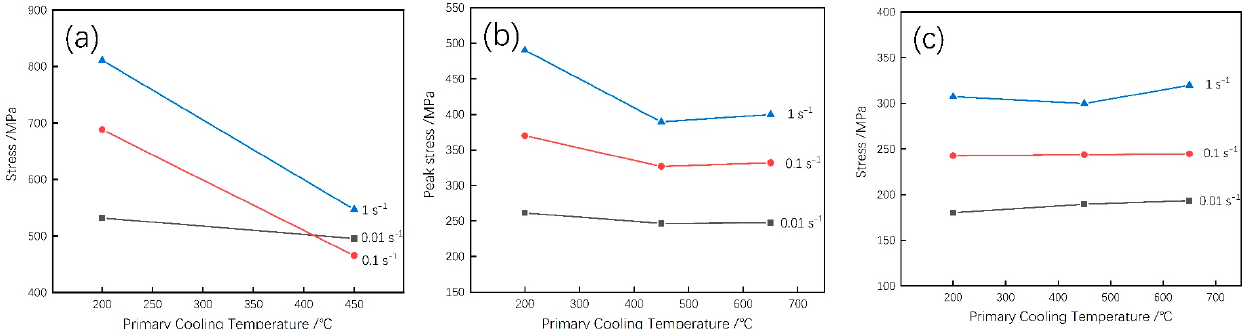
Figure 6. Influence of primary cooling temperature and strain rate at forming temperature of ( a ) 550 °C; ( b ) 650 °C; ( c ) 750 °C on peak stress.